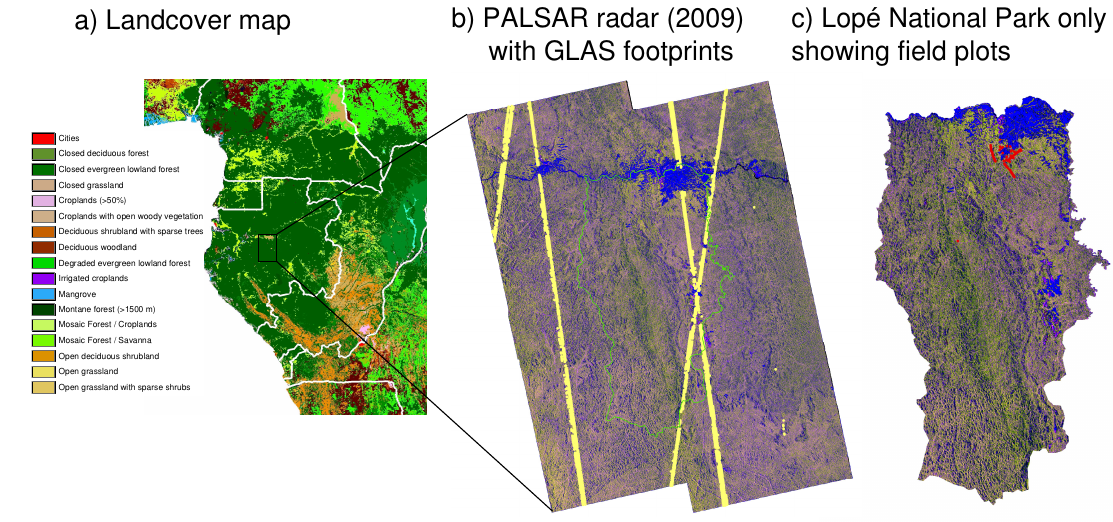
Fig. 1. (a) Map showing the location of the field site within a landcover map for the year 2000 (Mayaux et al., 2004), (b) Phased-Array L-band Synthetic Aperture Radar (PALSAR) mosaic (HH in red, HV in green, and HH/HV in blue) shown with the location of Geoscience Laser Altimeter System (GLAS) LiDAR footprints, after cloud- and slope- filtering, (c) the same radar image, but cut out around Lop´e National Park, showing the location of the field